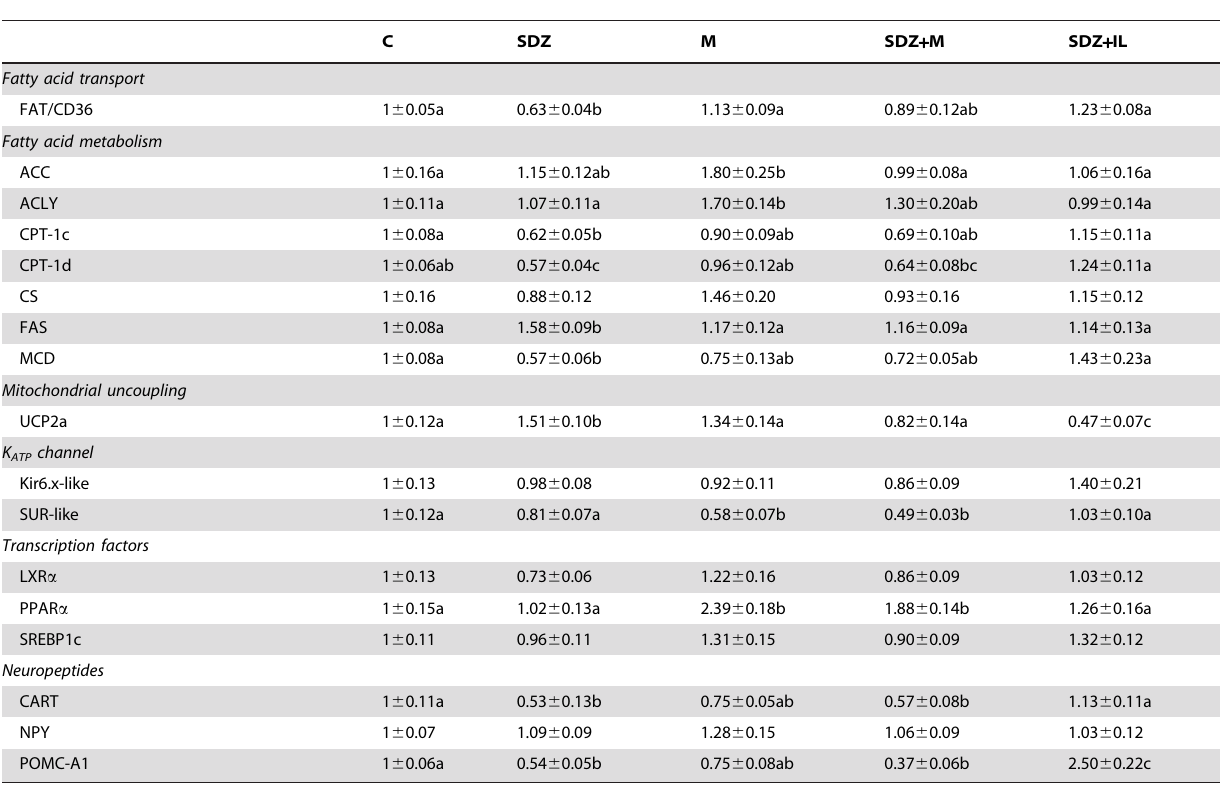
Data represent mean of 5 measurements. Data is expressed with respect to the control group (expression results were normalized by EF-1 a mRNA levels, which did not show changes among groups). Different letters indicate significant differences ( P , 0.05) among treatments.